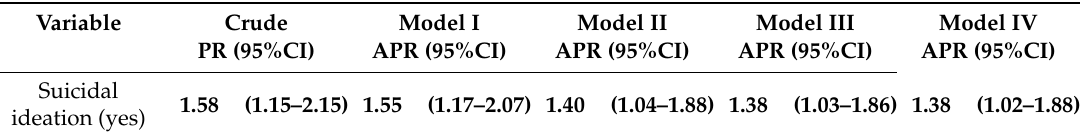
Table 2. Prevalence ratio with 95%CI for association between Childhood Mental Health and Geriatric Depression after multiple imputation ( n =